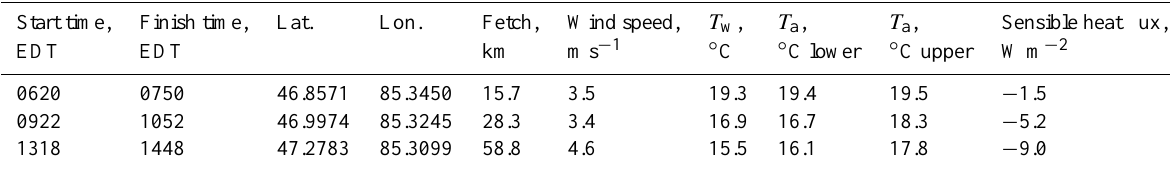
Table 1. Conditions at the three sampling stations in eastern Lake Superior on 14 July 2006, and average temperature at the upper (8.5m) and lower (1m) platforms. Start time, Finish time, Lat. Lon. Fetch, Wind speed, T w , T a , T a , Sensible heat flux, EDT EDT km ms − 1 ◦ C ◦ C